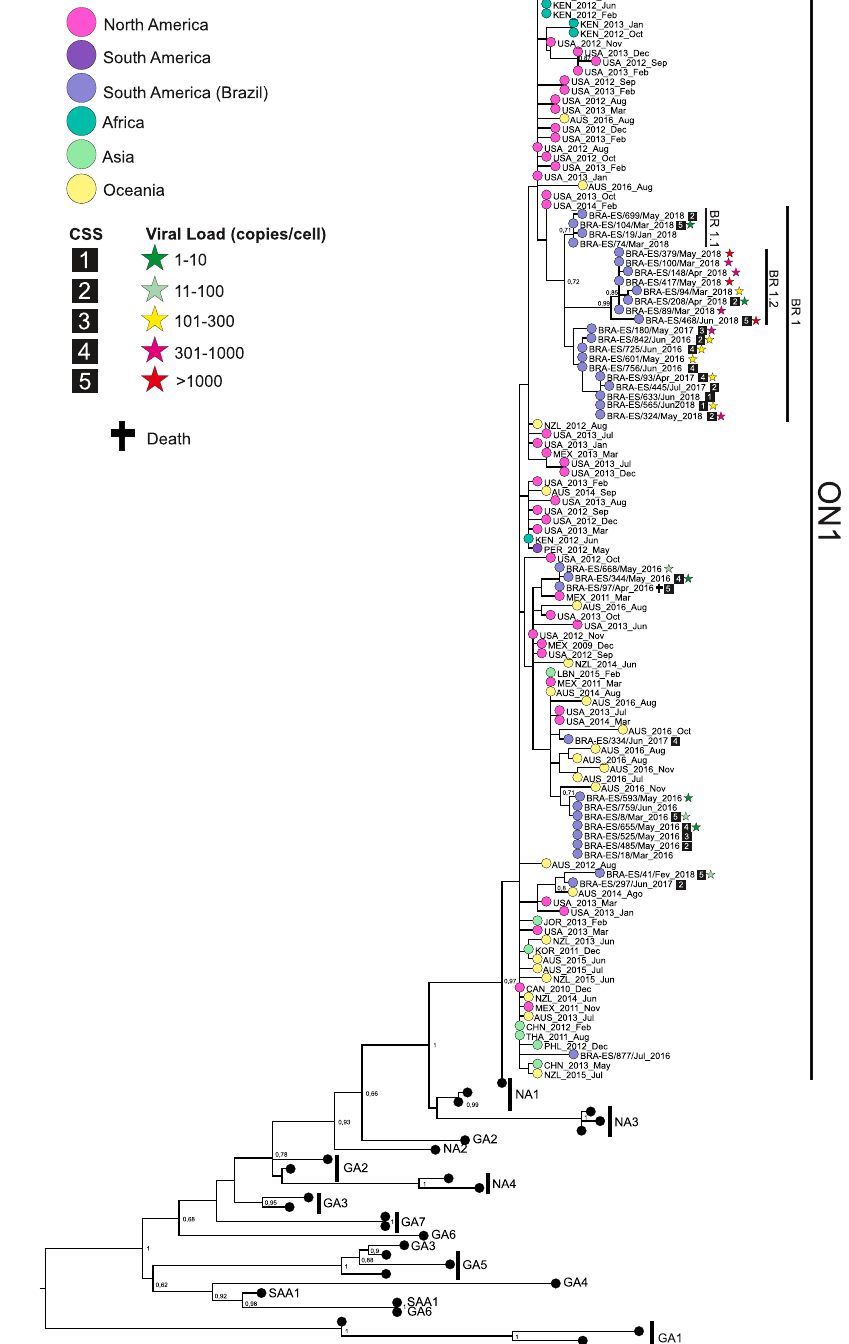
Fig 2. RSV-A phylogenetic tree. The tree was built using the maximum likelihood method on MEGA 6.0 software from a MUSCLE alignment of G gene sequences of 711 bp. Previously published sequences from known genotypes were retrieved from the NCBI database. Numbers from 1 to 5 within the squares indicate the patients’ CSS. The cross indicates patients who died due to RSV infection. The stars indicate the viral load, categorized by color (in copies per